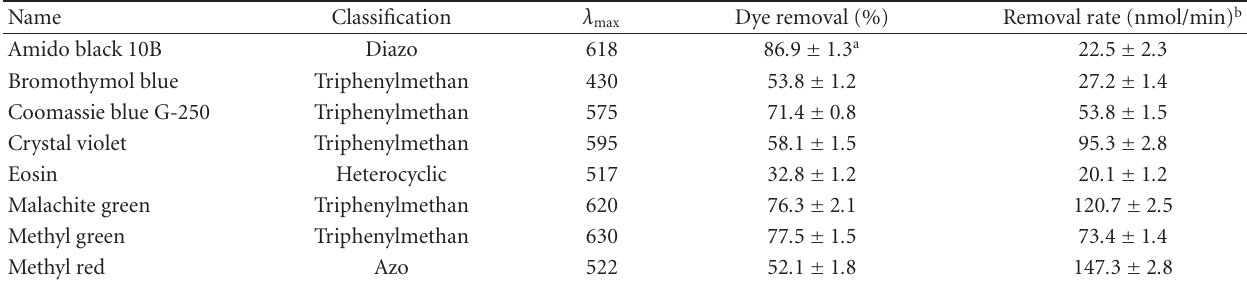
Table 1: Names, classification, maximum absorbance, and removal percentage of eight synthetic dyes using immobilized enzymes (in citrate bu ff er 0.1M, pH